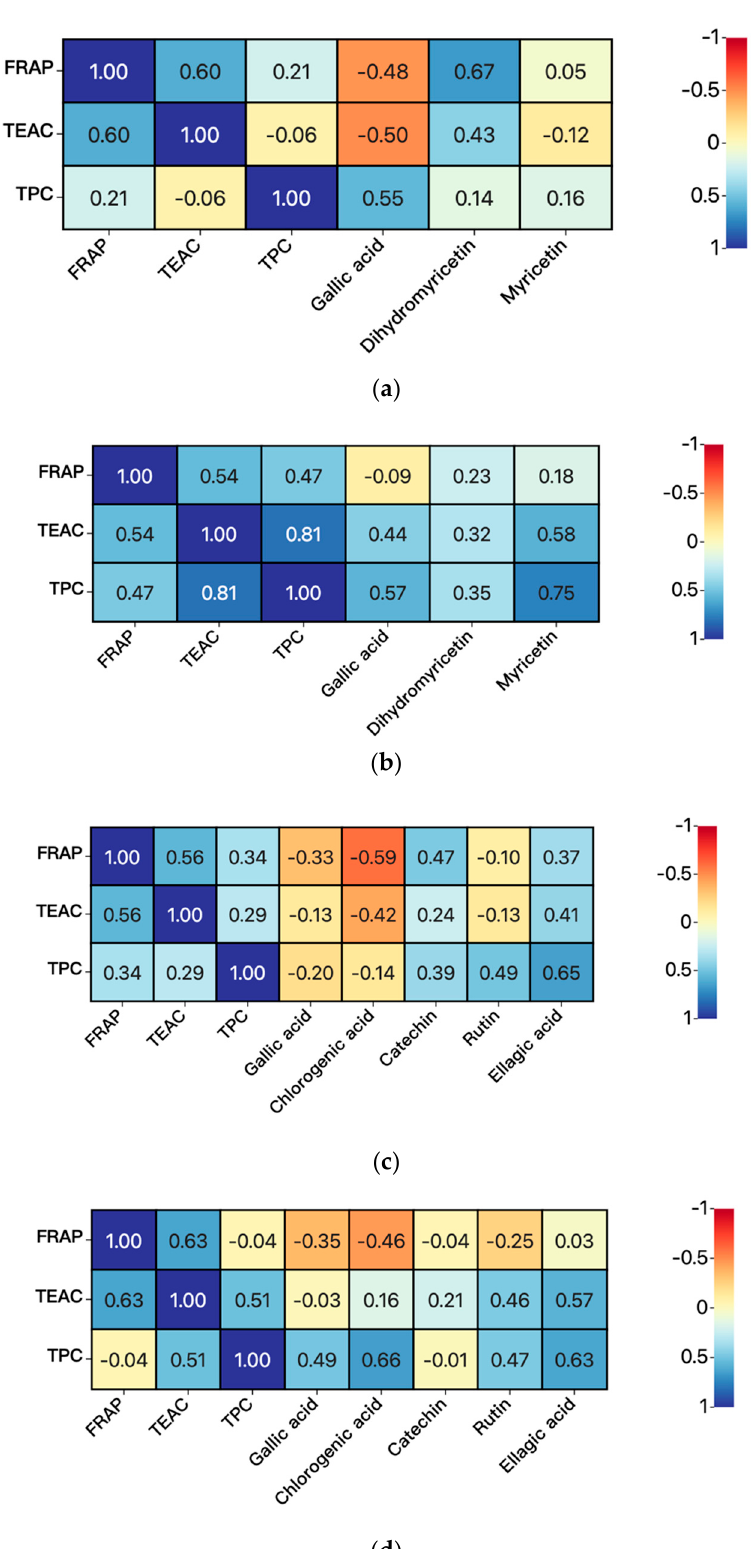
Figure 7. Heat maps analysis of the correlations between parameters and concentrations of com- pounds. ( a ) kombucha from vine tea without tea residues, ( b ) kombucha from vine tea with tea residues, ( c ) kombucha from sweet tea without tea residues, and ( d ) kombucha from sweet tea with tea